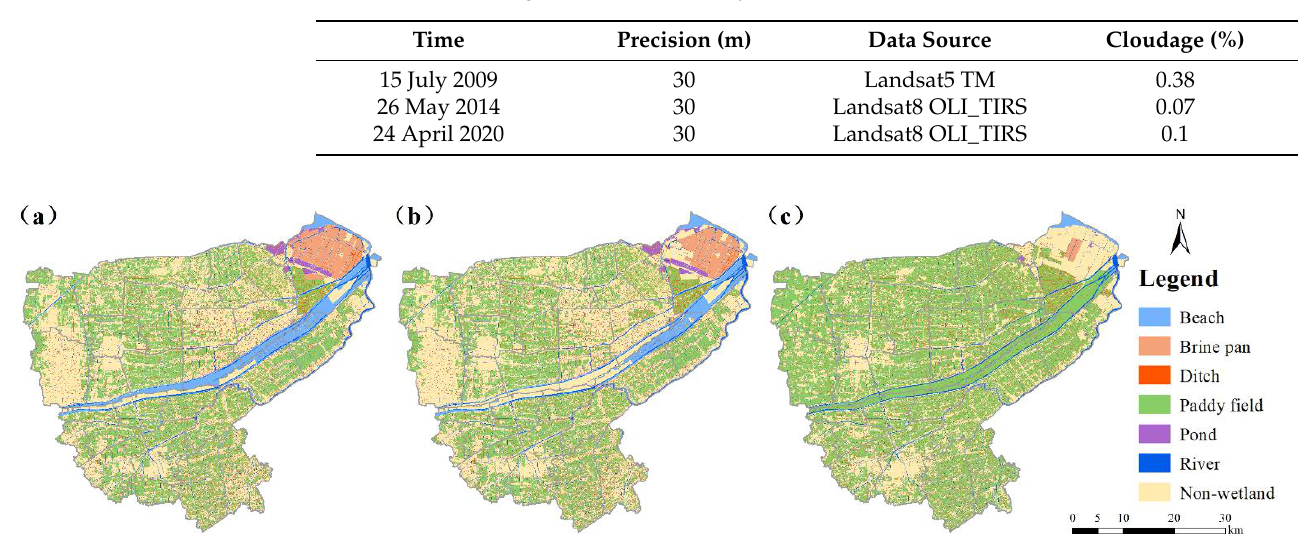
Table 1. Landsat images under in this study.